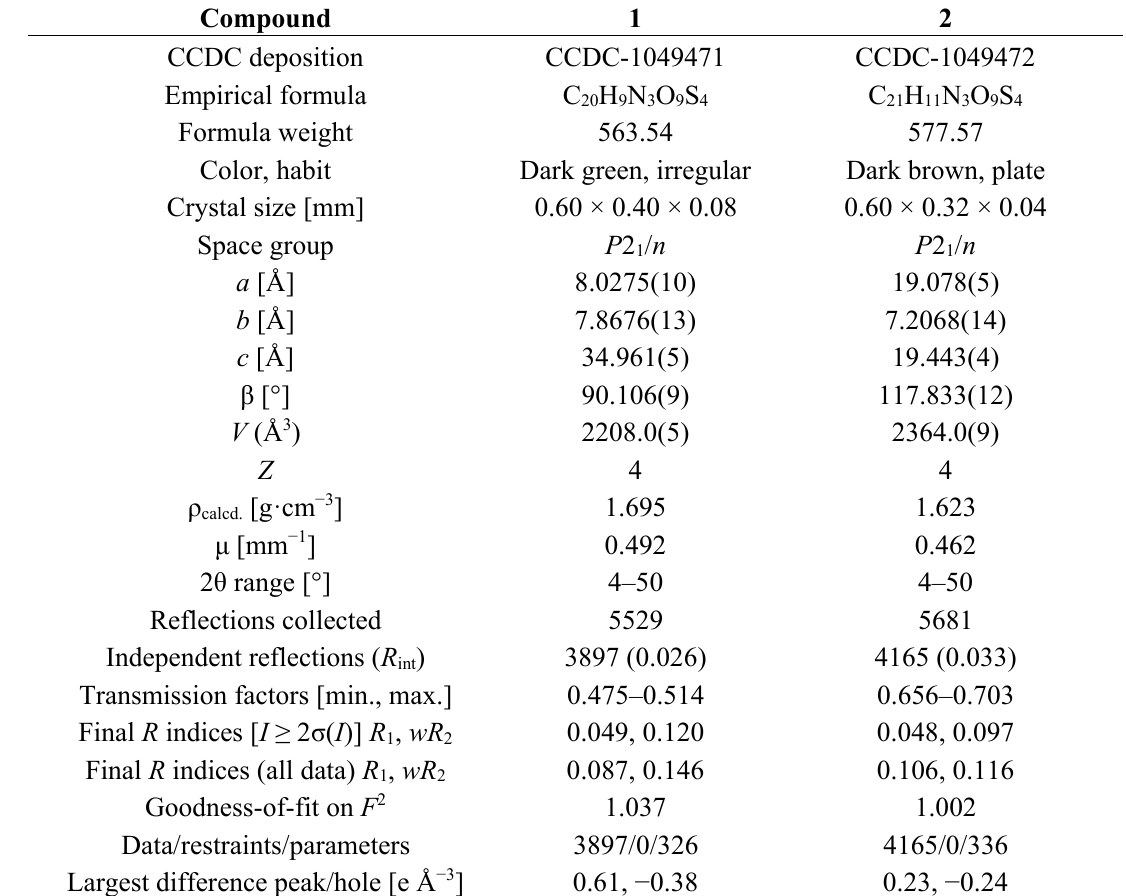
Table 1. Crystal data for complexes 1 and 2